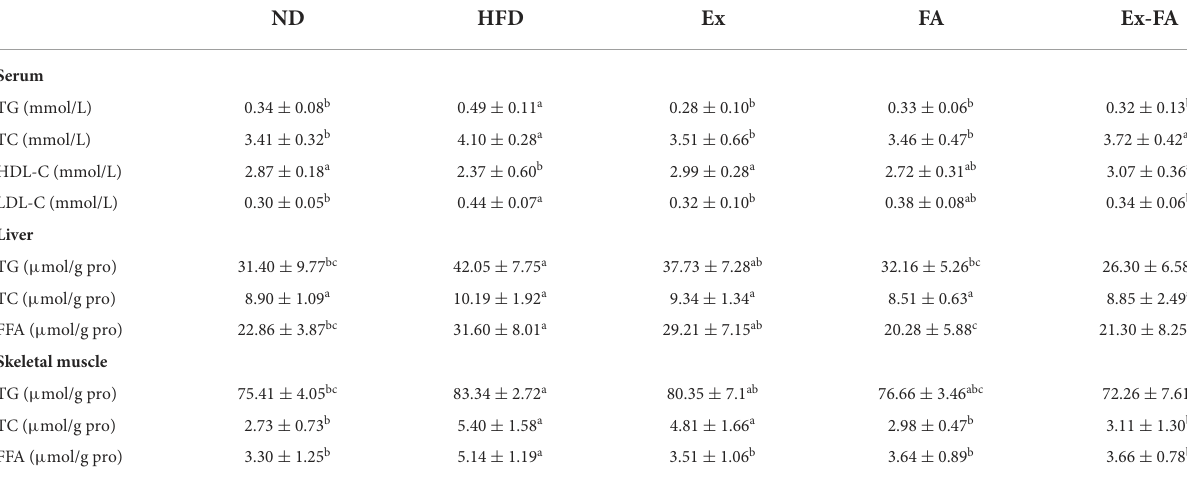
TABLE 1 Effects of Ex, FA, and Ex-FA on lipid profiles in the serum, liver, and skeletal muscle in HFD-fed mice. ND HFD Ex FA